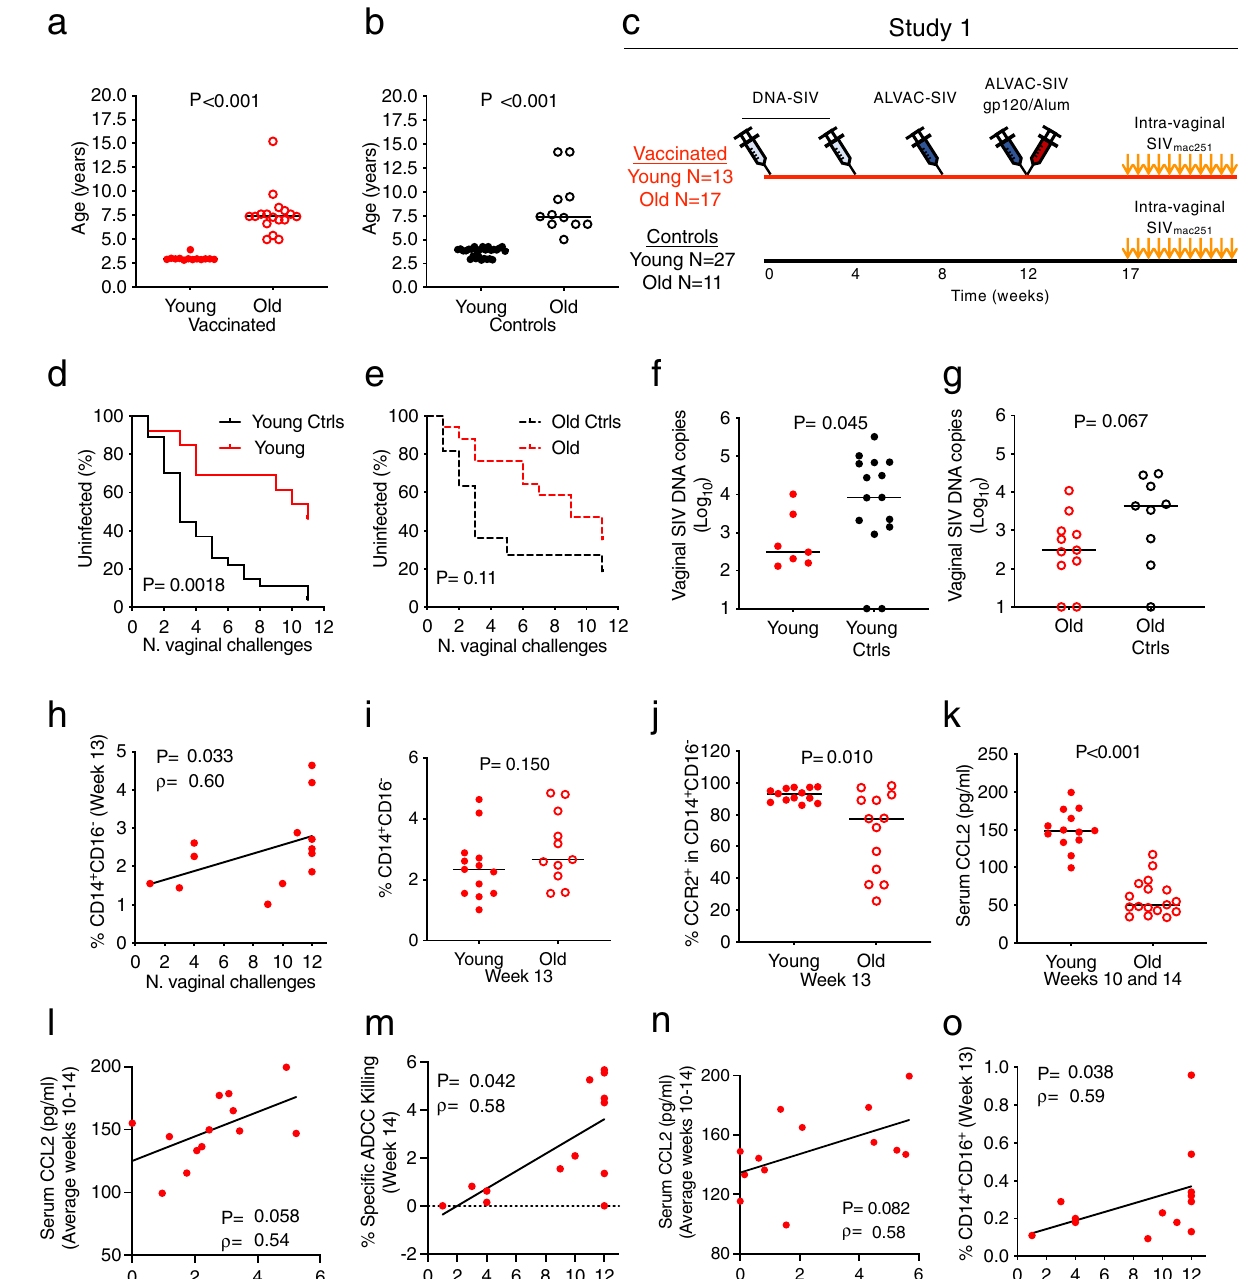
Fig. 1 | Study design,vaccine ef fi cacy, and monocytes. a , b Ageof vaccinated ( a ; p =0.00000002) and control ( b ; p =0.0000000017) animals. c Schematic study design of Study 1 with immunization schedule (weeks 0 – 12) and SIV mac251 chal- lenges (weeks 17 – 27). d , e SIV mac251 acquisition. The number of intravaginal expo- sures before infection was assessed in ( d ) n =13 young and ( e ) n =17 old animals relative to their n =27 young and n =11 old control animals (Log-rank Mantel-Cox test). f , g Log 10 of SIV-DNAcopies invaginalmucosa at2 – 3weeksafter infection in ( f ) n =7 vaccinated and n =15 control young animals; and ( g ) n =11 vaccinated and n =9 control old animals. h Correlation between the frequency of classical mono- cytes (CD14 + CD16 − HLA-DR + in live cells) at week 13 and the time of acquisition (TOA) in n =13 young animals. i Frequency of classical monocytes in n =13 young and n =11oldvaccinatedanimals(week13). j ClassicalmonocytesexpressingCCR2 (CCR2 + inCD14 + CD16 − cells)in n =13youngand n =13oldvaccinatedanimals(week